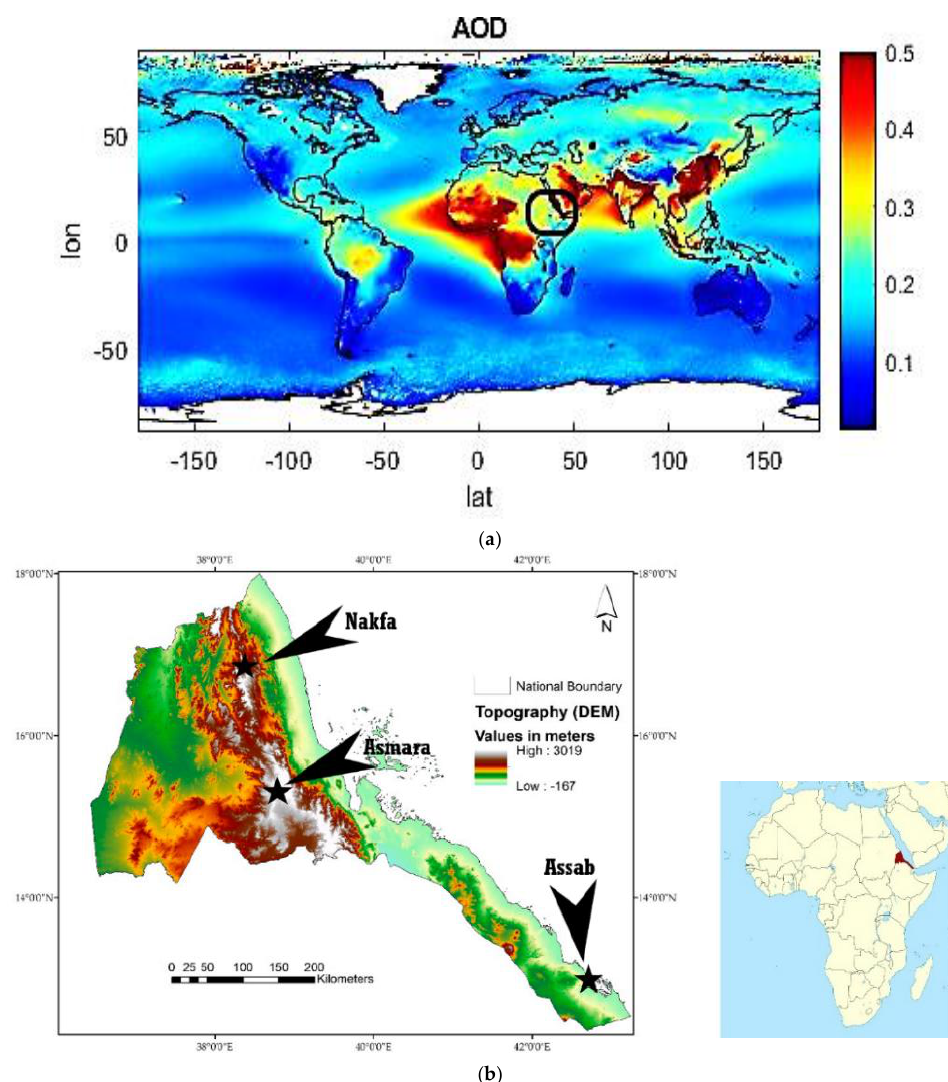
Figure 1. ( a ) Plot of the global distribution of aerosols around the world in the years (2001–2018). The color bar refers to the aerosol optical depth (AOD) and ( b ) topography [19] and geography of Eritrea [20].